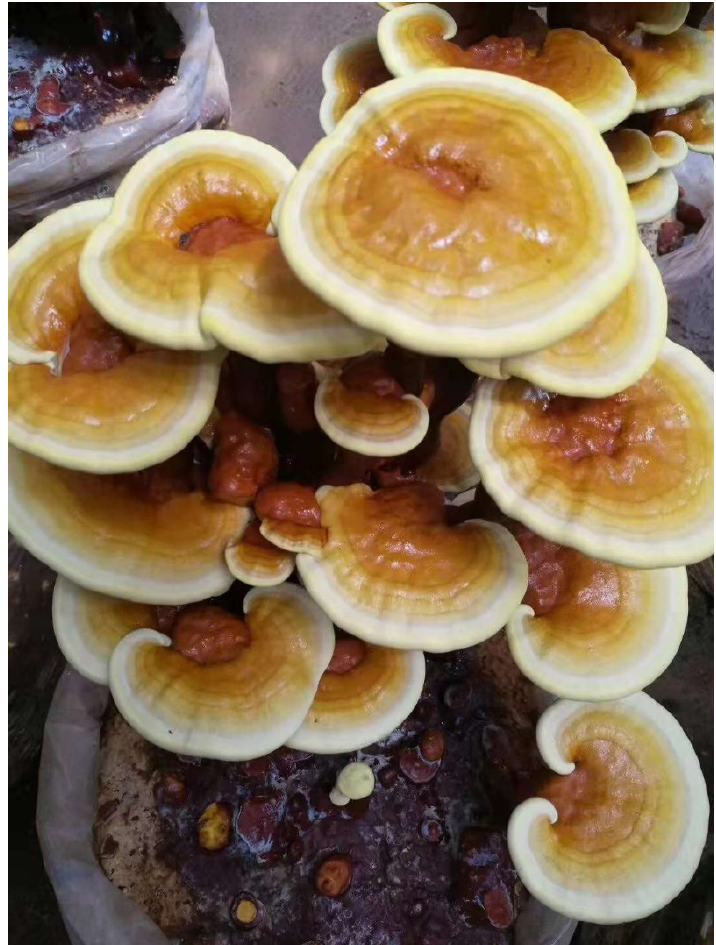
Figure 1. Image of Ganoderma lucidum.